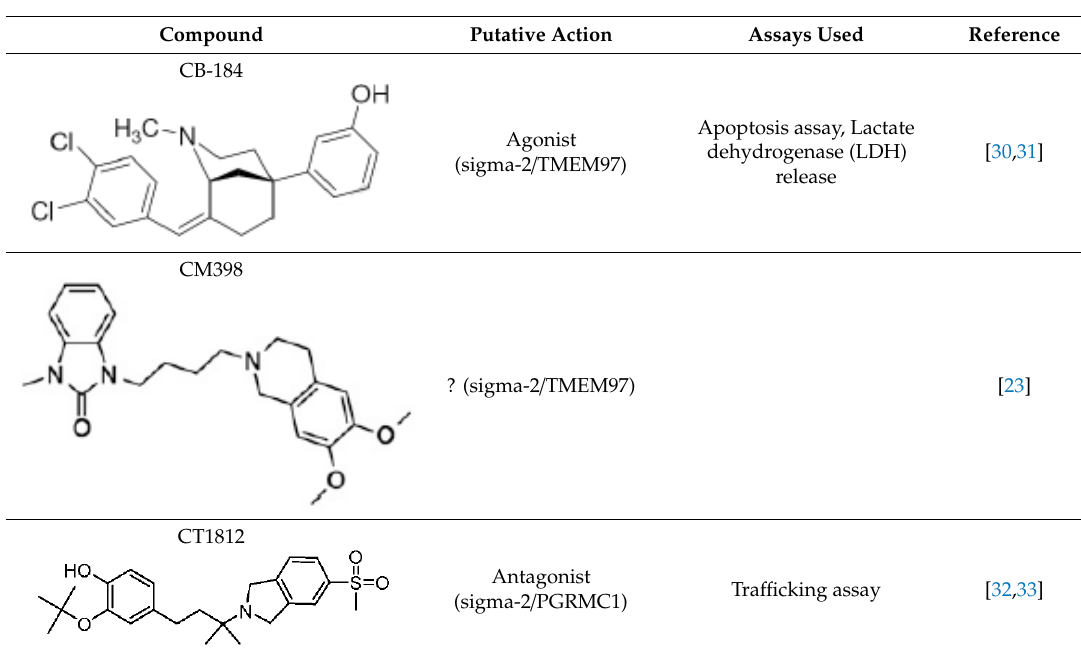
Table 1. The pharmacology of sigma-2 ligands.